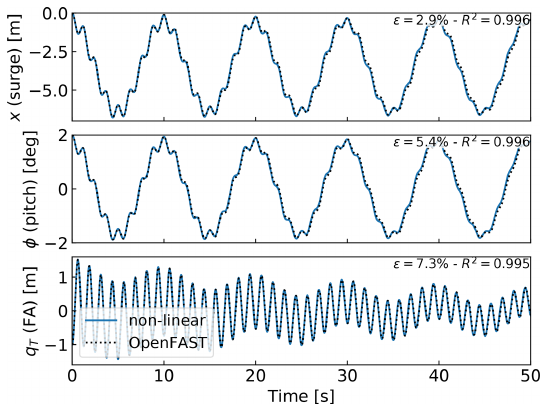
Figure 8. Free-decay results for the floating wind turbine model using YAMS and OpenFAST. From top to bottom: surge, pitch, and tower fore–aft